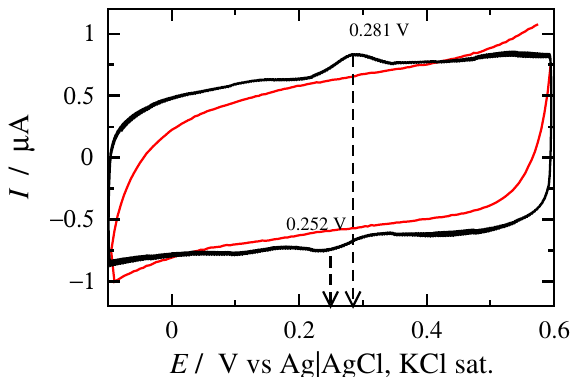
Figure 1. Experimental results: Cyclic voltammetry of Mt LPMO9H immobilised on a Co-f-MWCNTs modified GC electrode (black) and Co-f-MWCNTs modified GC electrode without enzyme (red) at 25 ◦ C. Experimental conditions: acetate buffer 500 mM (pH 6) and v = 0.1 V s − 1